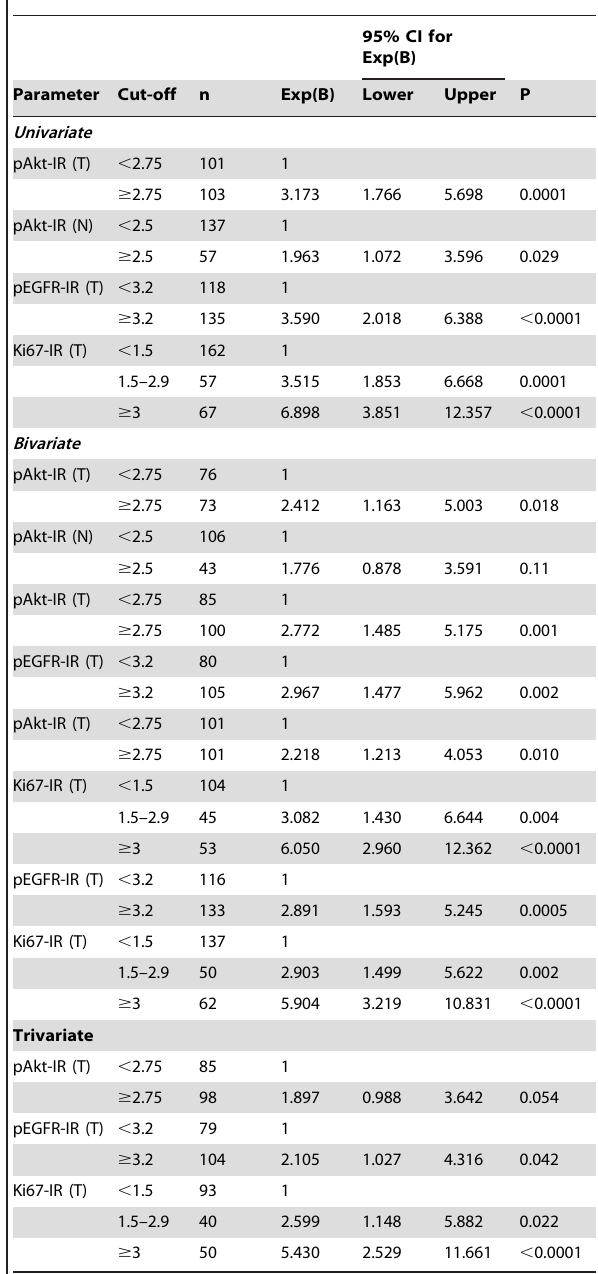
Table 4. COX proportional-hazards regression analyses for tumour and non-malignant pAkt-IR, tumour pEGFR-IR and Ki- 67-IR for patients followed by